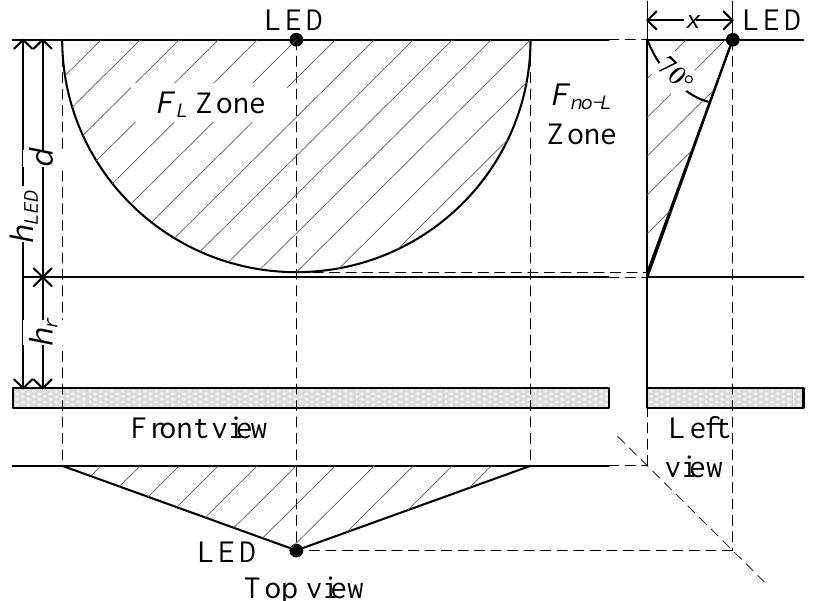
Figure 4. Schematic diagram of the calculation analysis of one infinitely long wall.